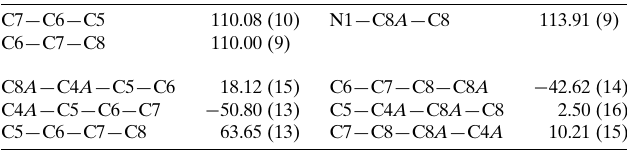
Table 4 Hydrogen-bond geometry (A˚ , (cid:3) ) for 1a